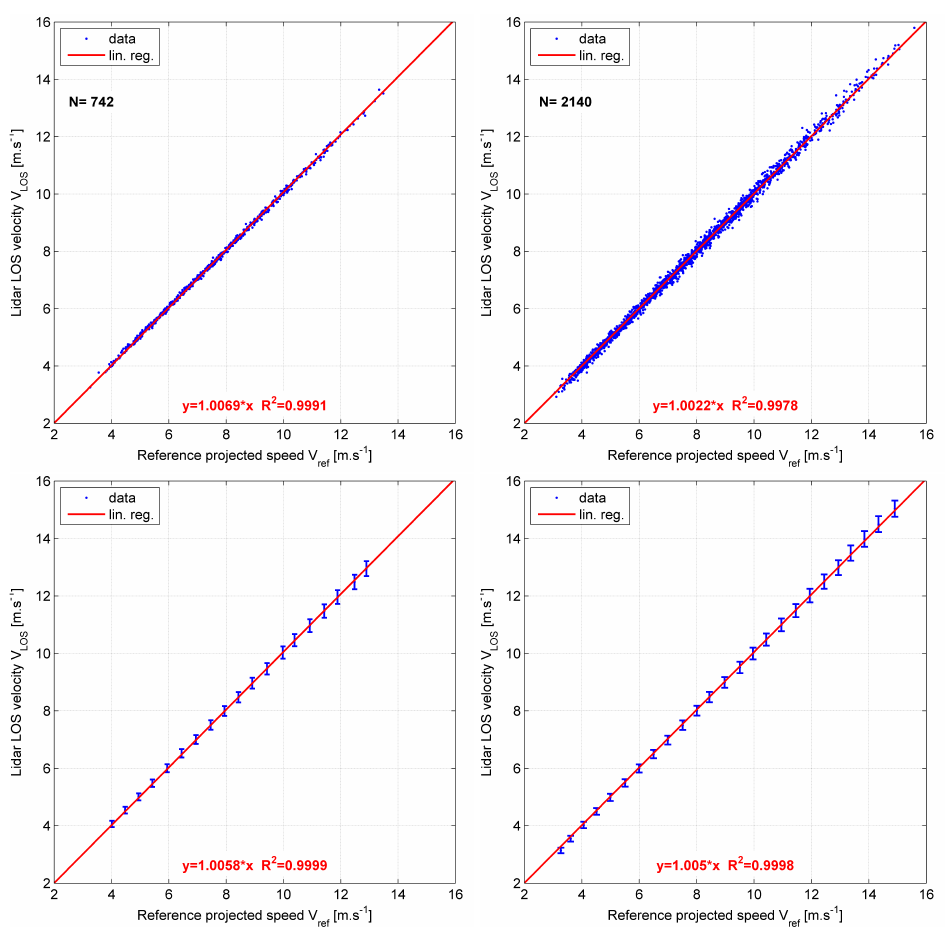
Figure 9. Calibration relation results. Left column : 5B; Right column : ZDM; Top row : 10-min data; Bottom row : binned data, including expanded uncertainties in error